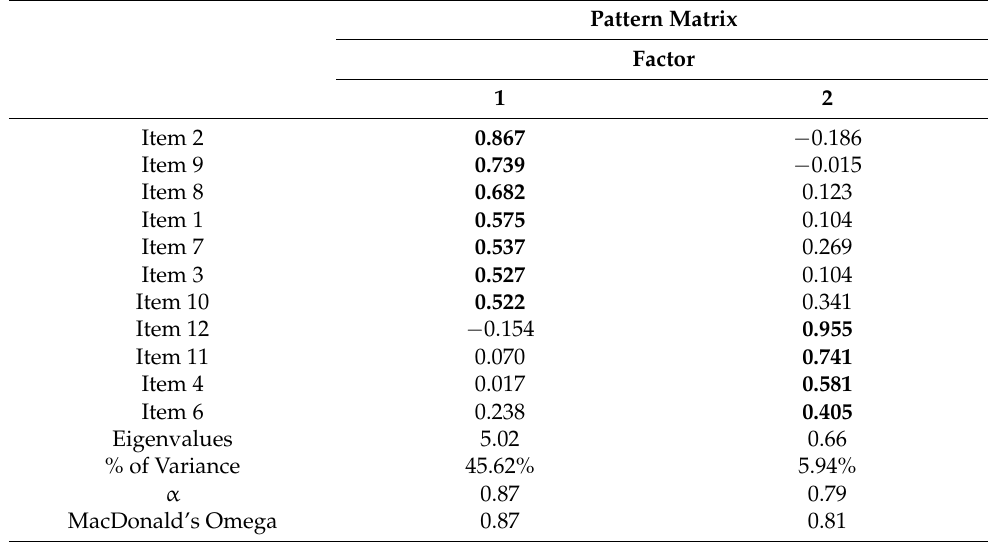
Table 5. The pattern matrix for the principal axis factor analysis on 11 of the GHQ-12 items. Pattern Matrix Factor 1 2 Item 2 0.867 − 0.186 Item 9 0.739 0.123 Item 1 0.575 0.104 0.537 0.269 0.527